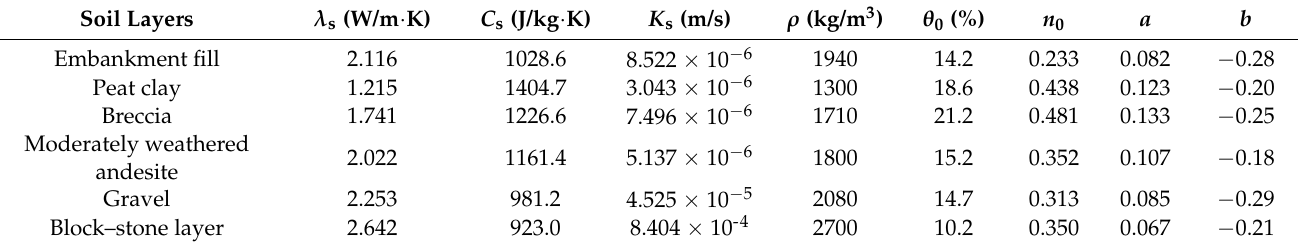
Table 2. Physical parameters of the soil